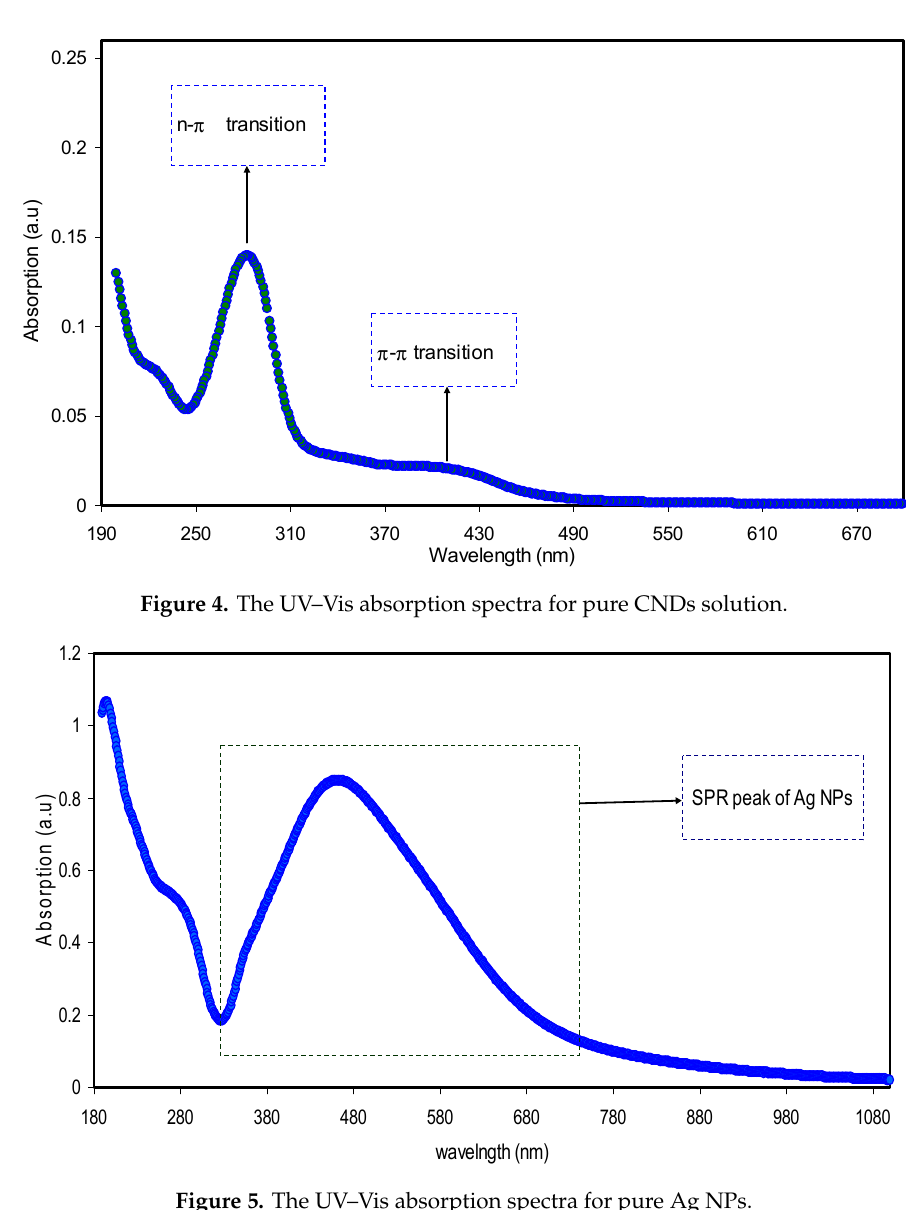
Figure 5. The UV–Vis absorption spectra for pure Ag Figure 5. The UV – Vis absorption spectra for pure Ag NPs. Figure 5. The UV – Vis absorption spectra for pure Ag NPs.